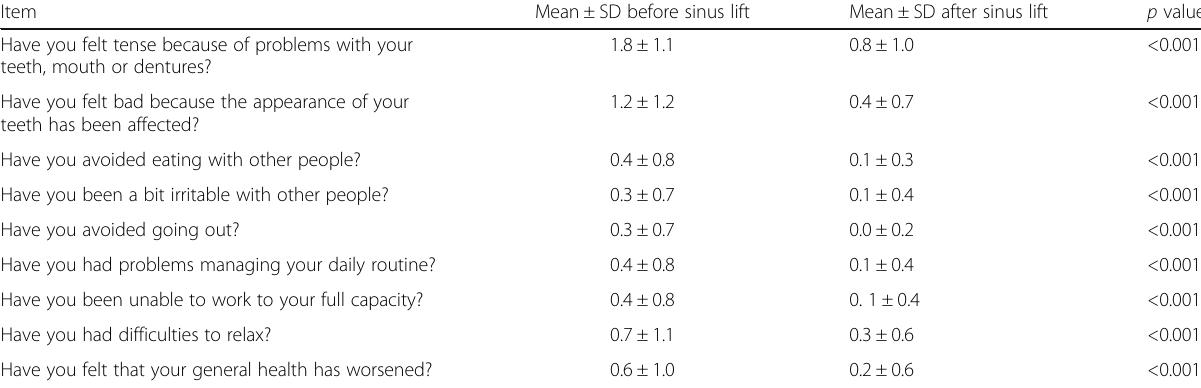
Table 2 Mean value and standard deviation for the subcategory physical and psychological disabilities Item Mean ± SD before sinus lift Mean ± SD after sinus lift p